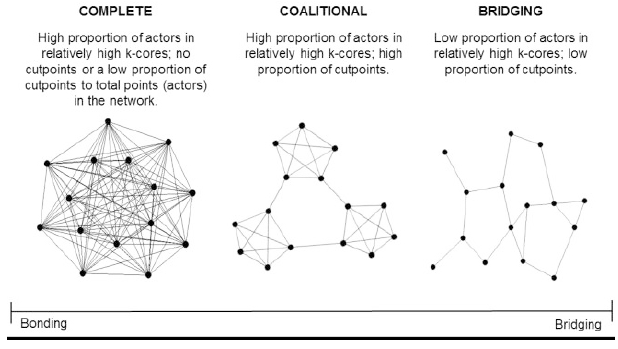
Fig. 2 . Example of a complete, coalitional, and bridging network classified by Crowe’s (2007) framework for analyzing community network structures, adapted from Ramirez-Sanchez and Pinkerton